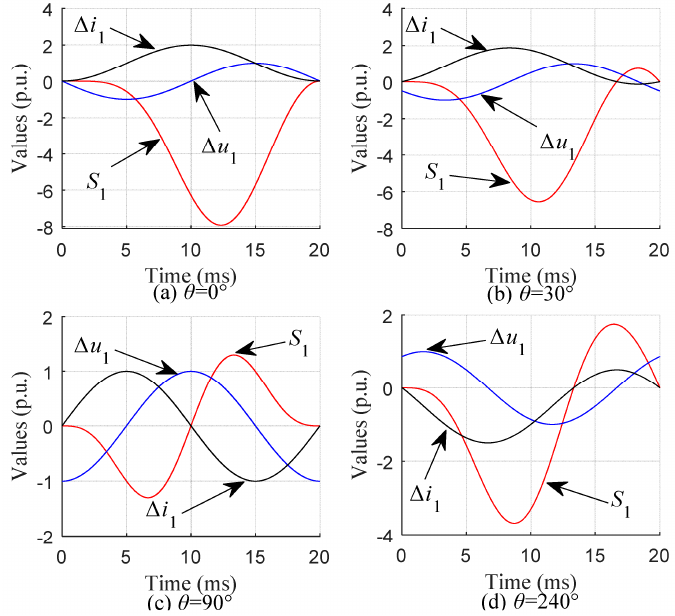
∆ i Figure 4. Δ u 1 , Δ i 1 , and S 1 detected by R 1 for a fault on l 1 . Figure 4. ∆ u 1 , 1 , and S 1 detected by R 1 for a fault on l 1